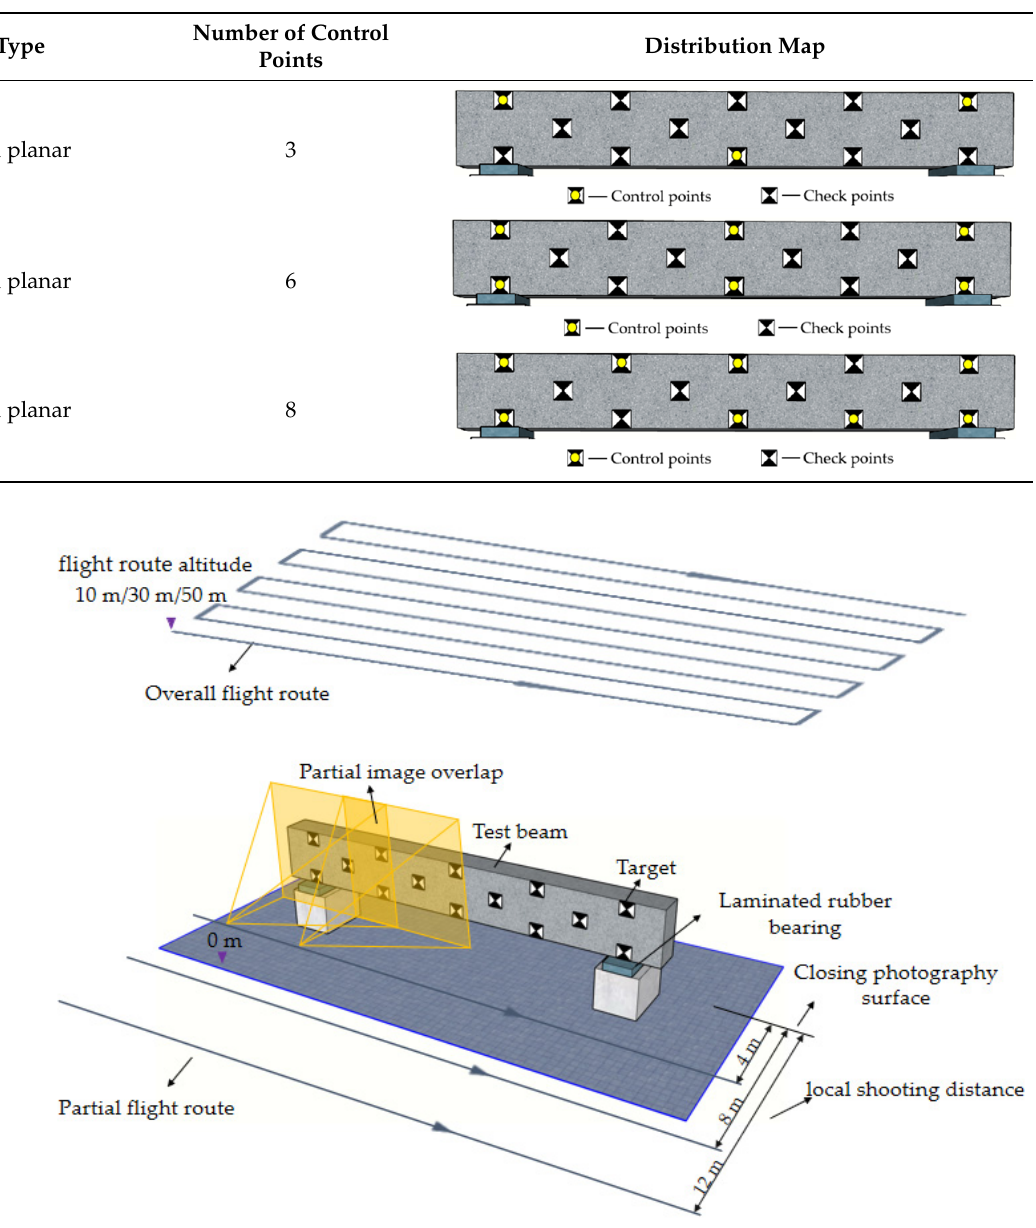
Figure 6. The detailed arrangement of the checkpoints (Unit: m). Due to the uncertain influence of complicated environments and traffic vehicles, it is impractical to keep control points on the top surface of bridge decks for a comparatively long monitoring period. The control points on the bridge’s side surfaces are easy to protect during the bridge’s construction and operation stages. Consequently, as shown in Table 2, the control points were attached to the side surface of the concrete beam. A total of fourteen reference points were used. Specifically, the location of control points is catego- rized as global layout (G), regional layout (R), linear layout (L), and planar layout (P). The control points include 3, 6, and 8 for different point arrangements.